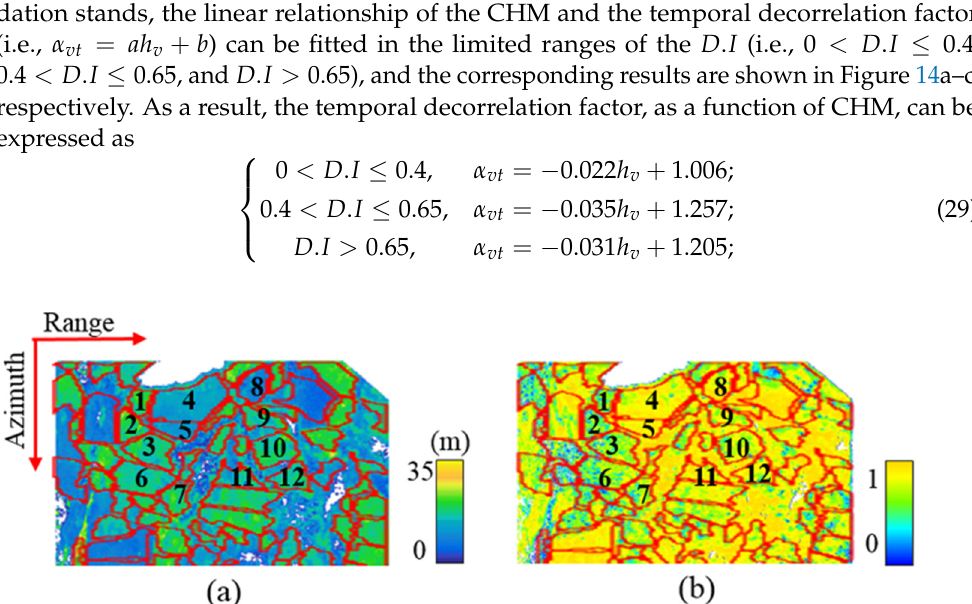
Figure 13. Validation stands for the estimation of the temporal decorrelation factor (red polygons). ( a ) The LiDAR-derived CHMs. ( b ) The temporal decorrelation factors derived from the RVoG + VTD model.